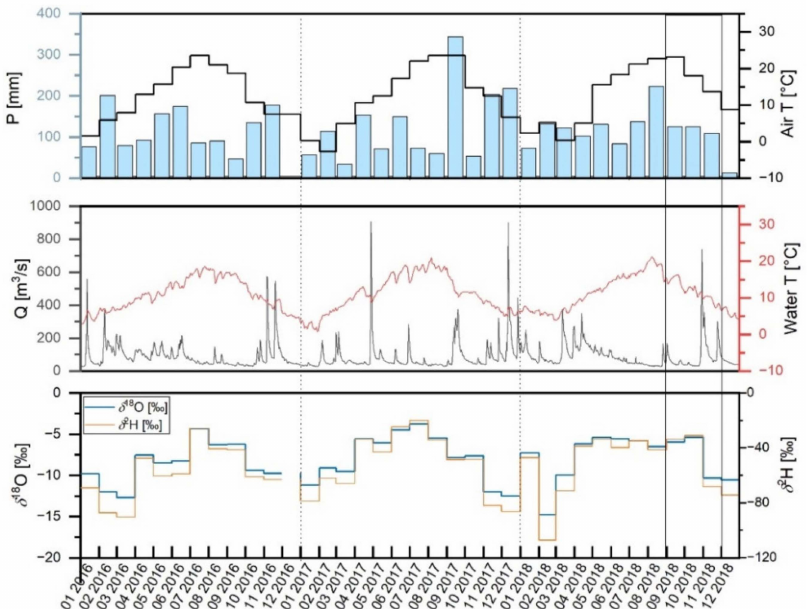
Figure 2. Monthly precipitation totals (mm), average monthly air temperature ( ◦ C), water flow (m 3 /s), water temperature ( ◦ C) and δ 2 H, δ 18 O in precipitation during 2016–2018. The sampling period September–November 2018 is marked with black